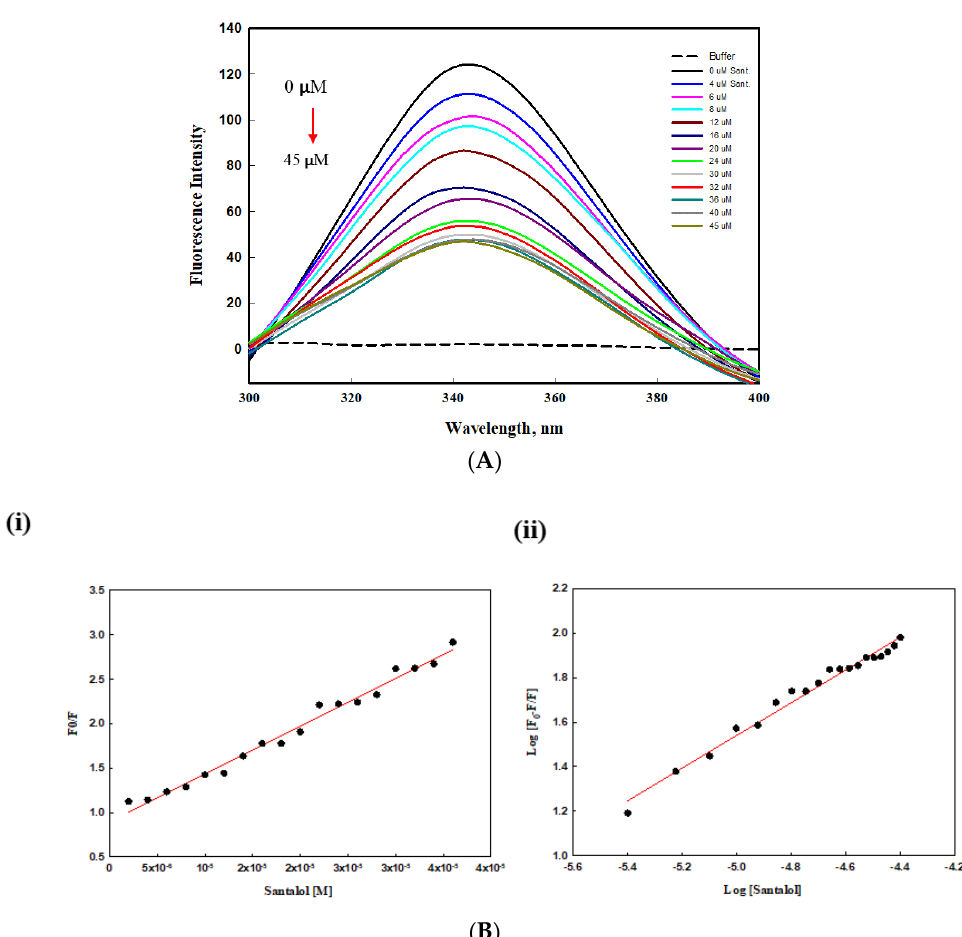
Figure 5. ( A ) Intrinsic fluorescence spectra of tyrosinase in the presence santalol at various concentrations, which range from 0 to 45 µM for top to bottom curves, respectively. ( B ) Stern-Volmer ( i ) and modified Stern - Volmer plots ( ii ) for the fluorescence quenching of tyrosinase at 25 °C by santalol (tyrosinase – santalol).